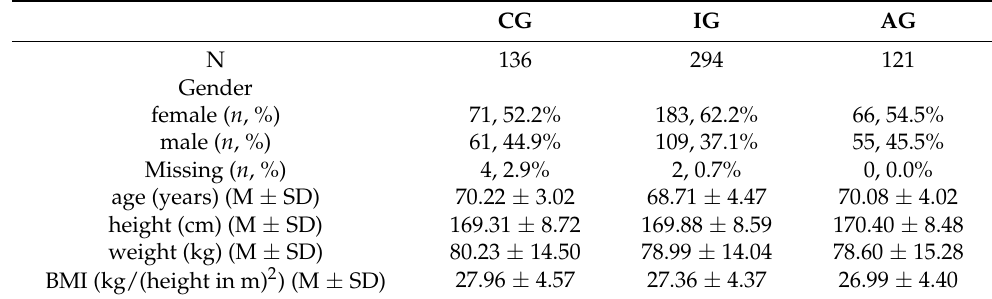
Table 1. Anthropometric data (mean = M and standard deviation = SD) of the participants recorded by self-report via questionnaire. CG = control group; IG = intervention group without activity tracker; AG = activity tracker group receiving the same web-based intervention as the IG. CG IG AG N 136 294 121 Gender female ( n , %) 71, 52.2% 183, 62.2% 66, 54.5% male ( n , %) 61, 44.9% 109, 37.1% 55, 45.5% Missing ( n , %) 4, 2.9% 2, 0.7% 0, 0.0% age (years) (M ± SD) 70.22 ± 3.02 68.71 ± 4.47 70.08 ± 4.02 height (cm) (M ± SD) 169.31 ± 8.72 169.88 ± 8.59 170.40 ± 8.48 weight (kg) (M ± SD) 80.23 ± 14.50 78.99 ± 14.04 78.60 ± 15.28 BMI (kg/(height in m) 2 ) (M ± SD) 27.96 ± 4.57 27.36 ± 4.37 26.99 ±